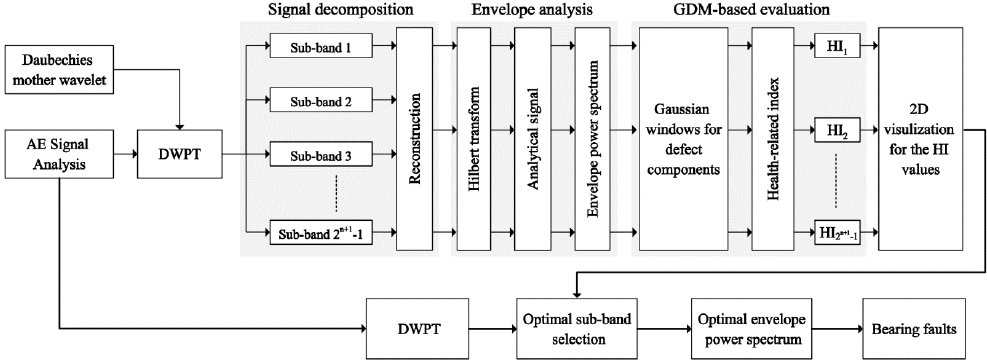
Figure 2. The overall block diagram of a proposed bearing fault detection system.